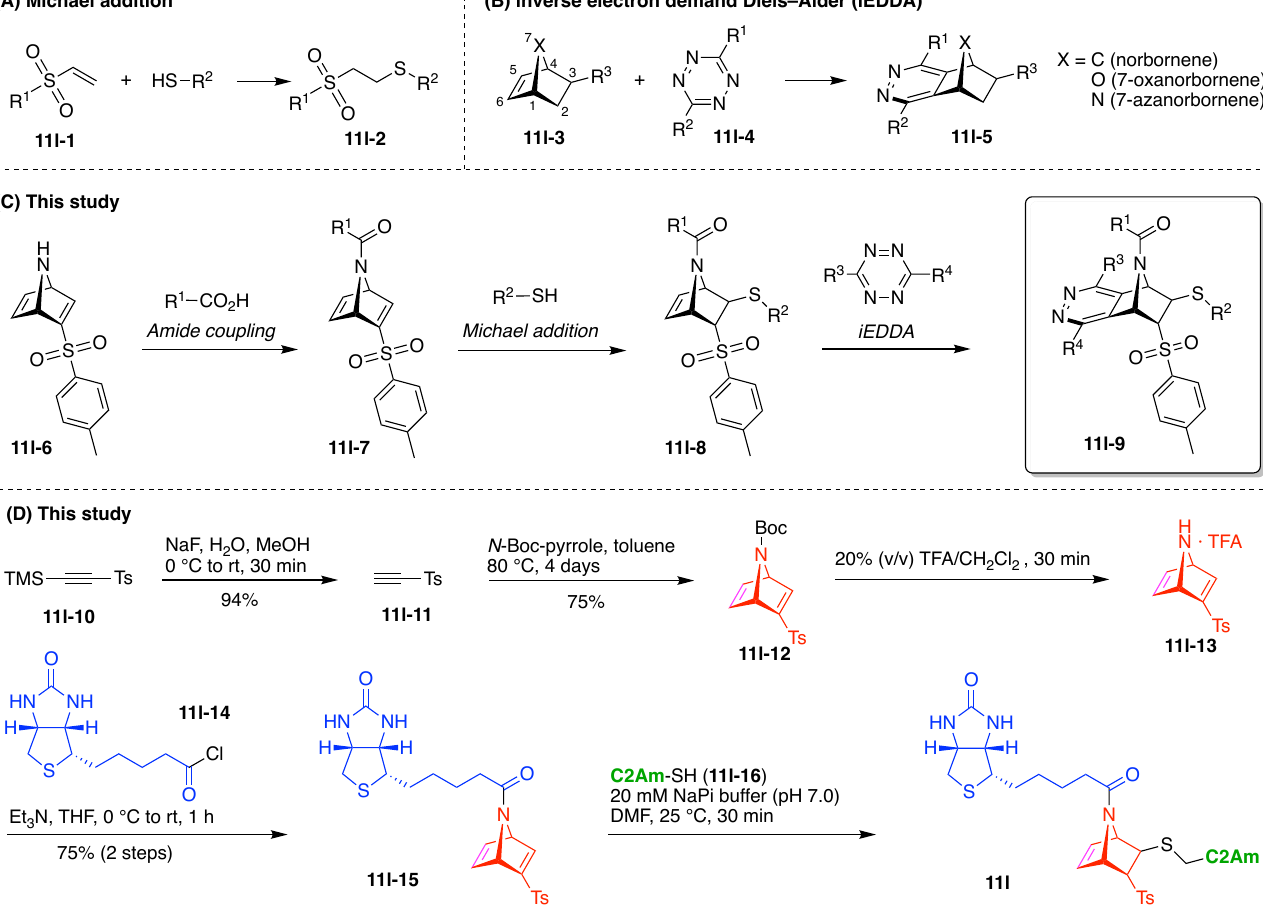
Figure 58. Orthogonal bioconjugation reactions ( A – C ). Synthesis of the azanorbornadiene reagent for protein modification ( D ).